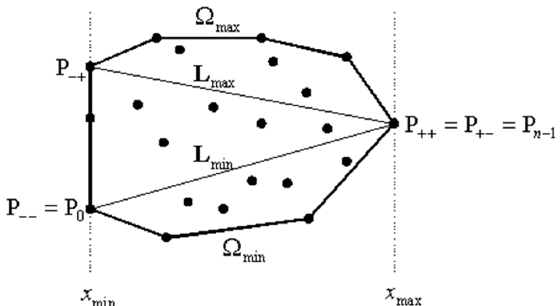
Figure 8. Convex hull for a point set and points defined: original point cloud - black dots, Ω - convex chain, lines L _min and L _max connect external, extreme points ( P _minmin, P _minmax, P _maxmin, P _maxmax). [49].